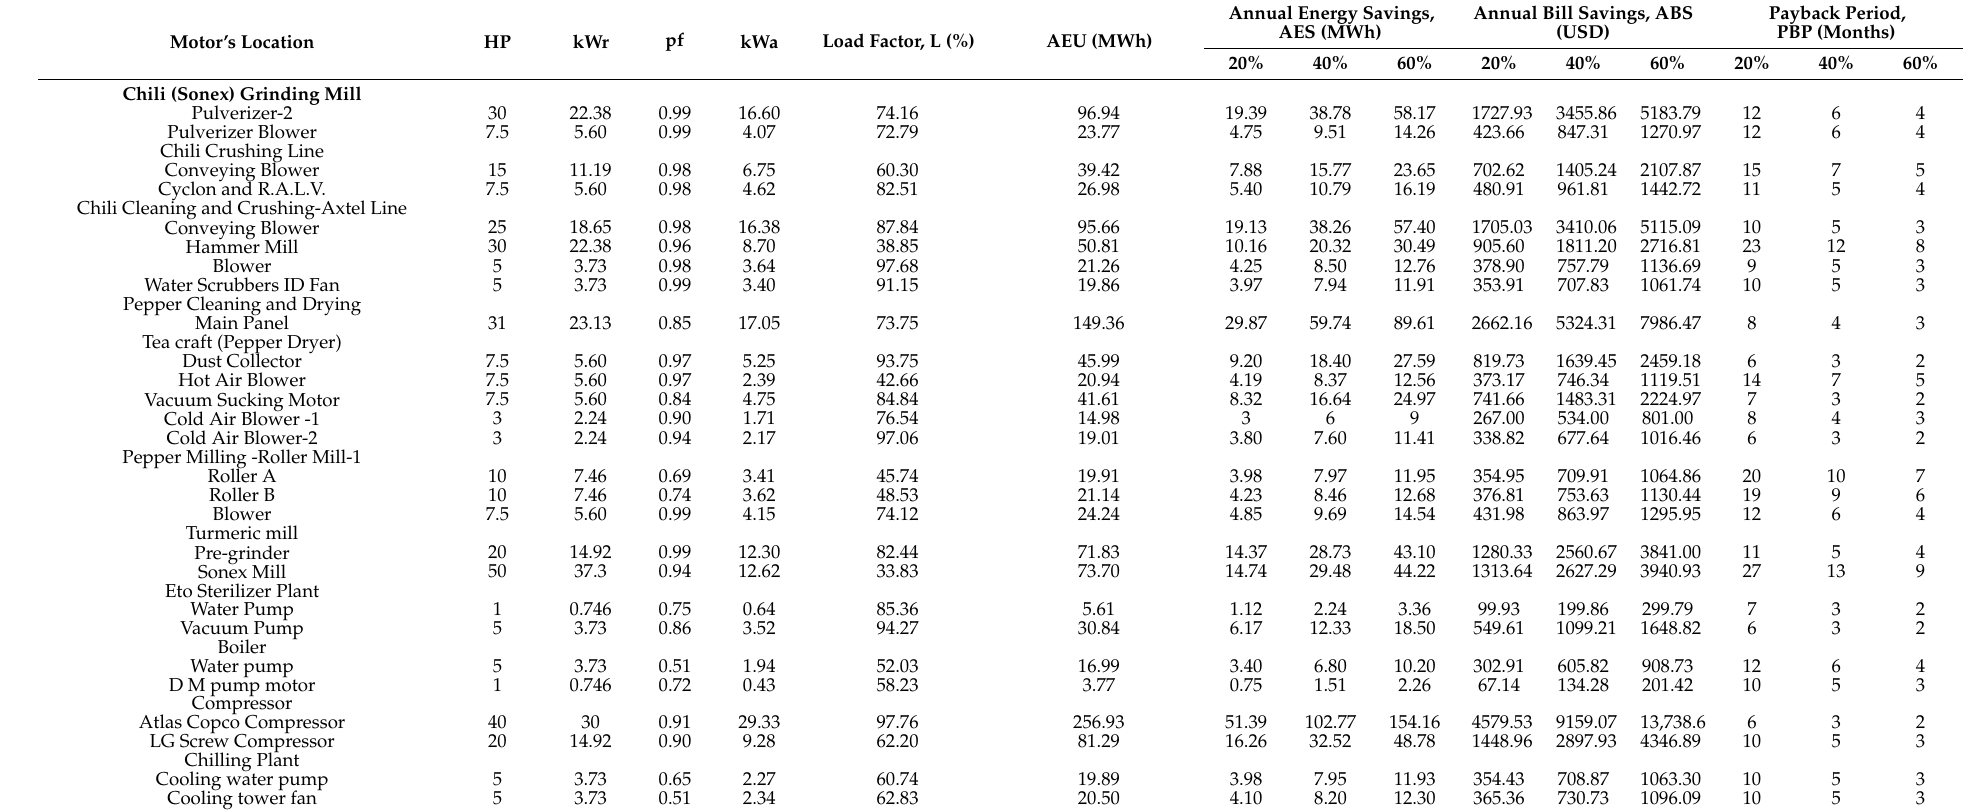
Table 13. Load details with energy use, savings and corresponding payback periods on motors and